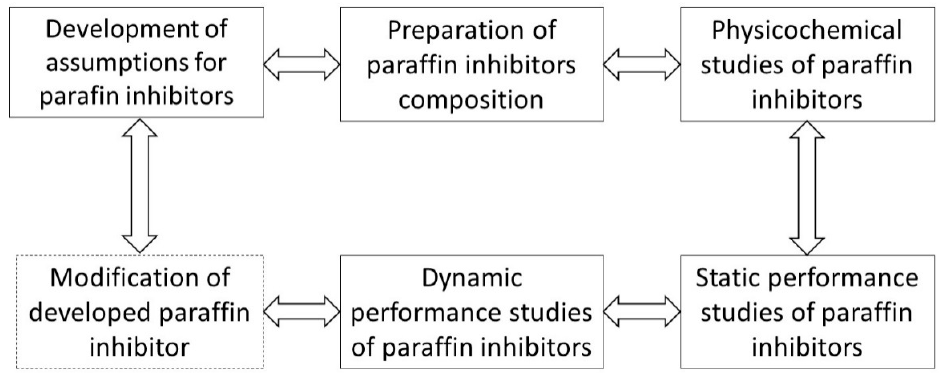
Figure 1. Scheme of the conducted research.